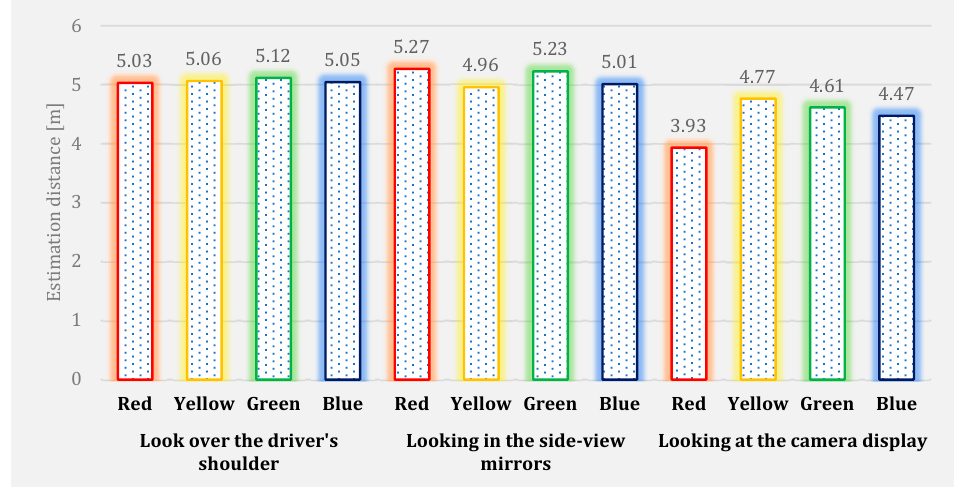
Figure 6. The estimation of the distance to the object for all conditions and all colors. The participants estimated the distance to the blue and green objects with the highest Table 1. Descriptive statistics of the estimation of the distance to the object. error in all described conditions. Table 2. The mean error of the estimation of the distance to the object.